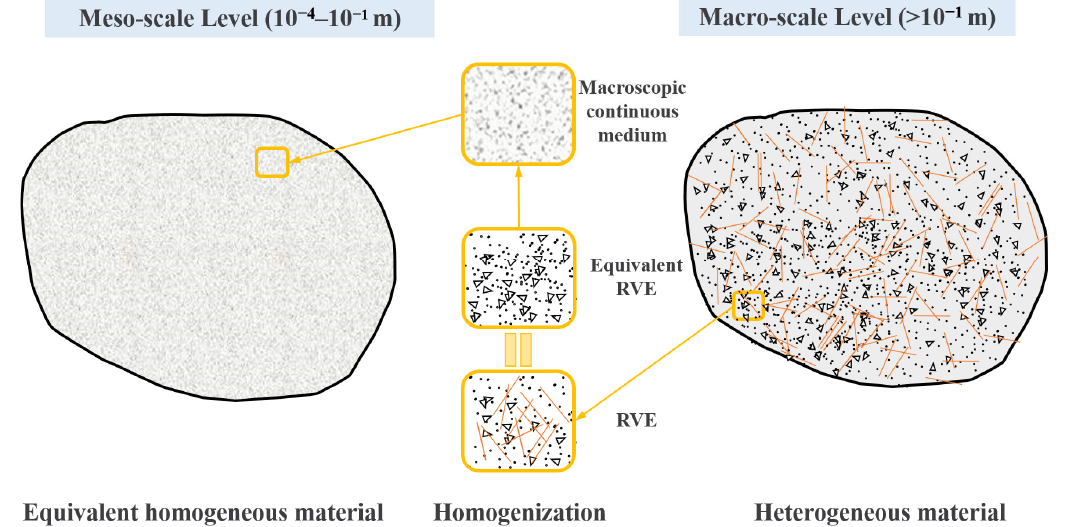
Figure 18. The equivalent transformation between mesoscale and macroscale view in mortar.